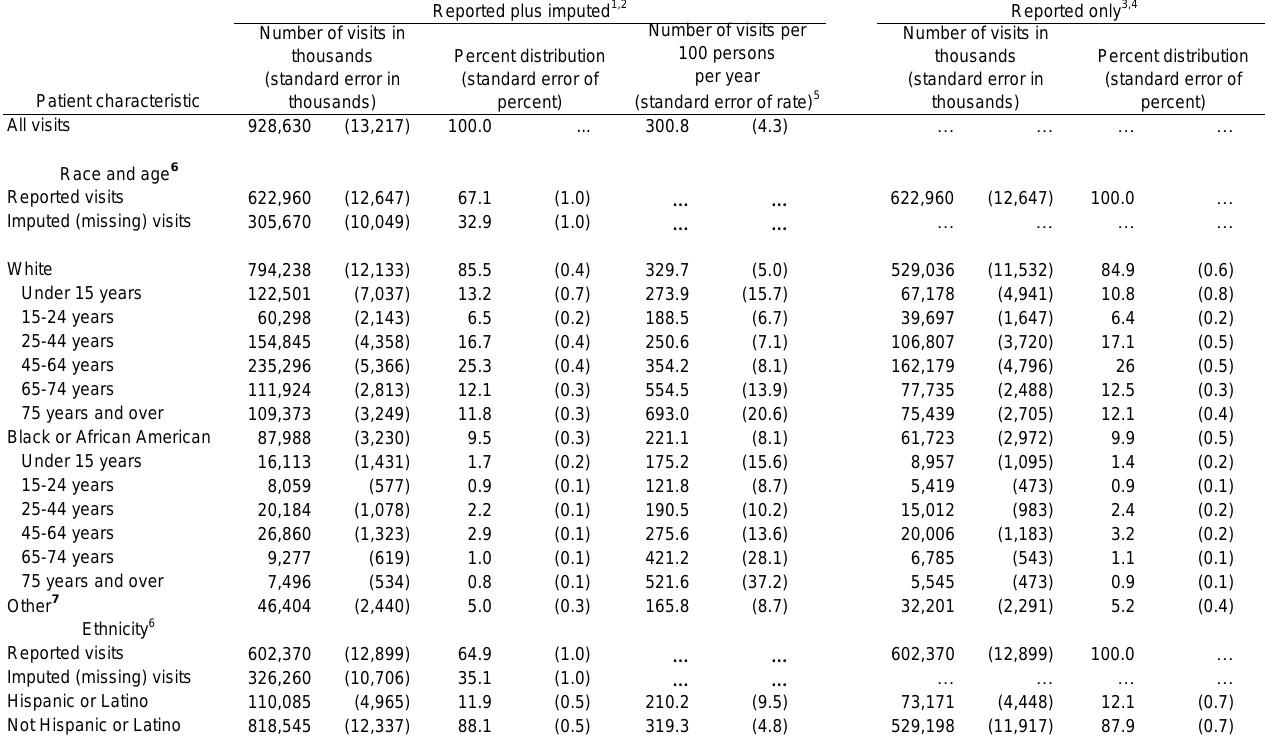
Table 6. Office visits, by patient race and age, and ethnicity: United States,